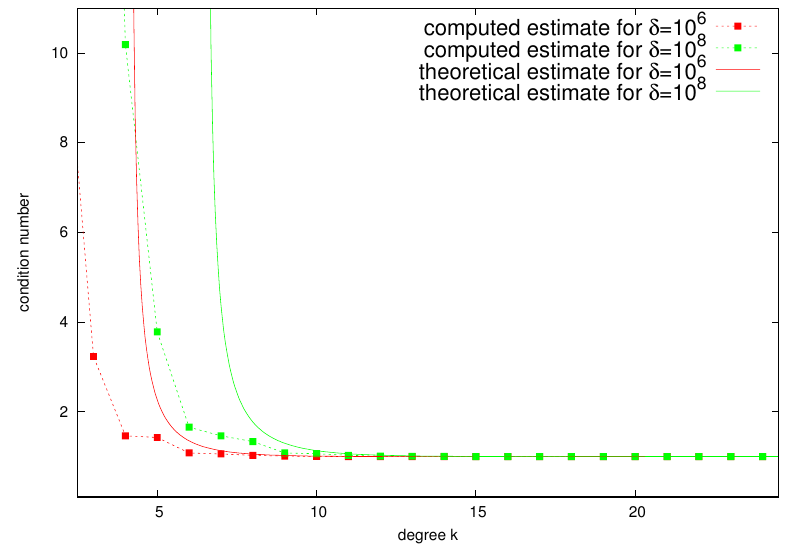
Figure 3. Theoretical estimates (21) vs. computed estimates (22) of κ